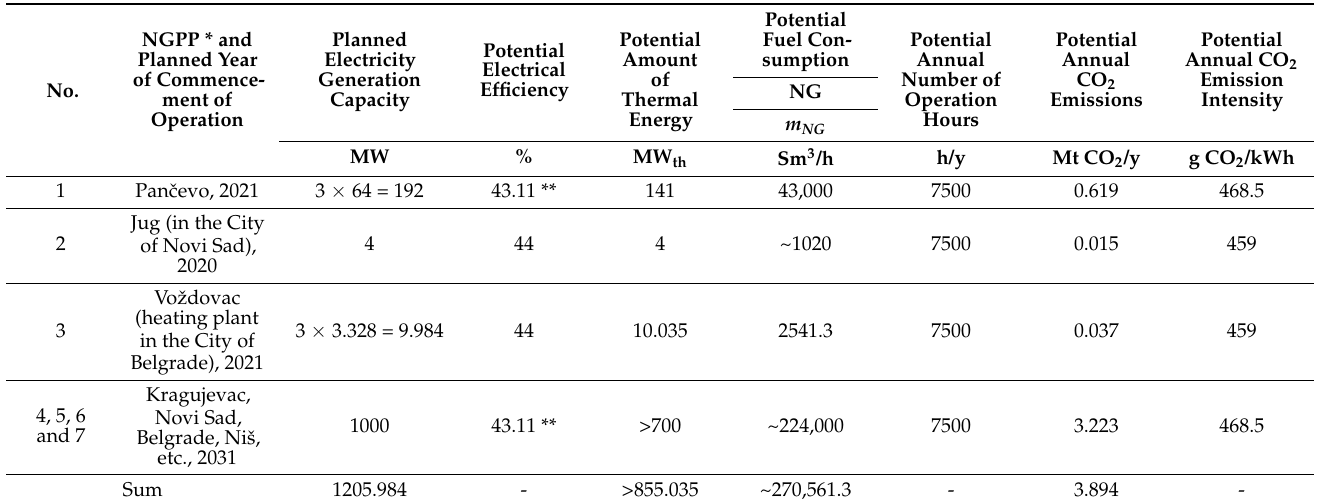
Table 3. An overview of the potential values of the performance indicators, annual CO 2 emissions, and annual CO 2 emission intensity for the planned NGPPs in Serbia